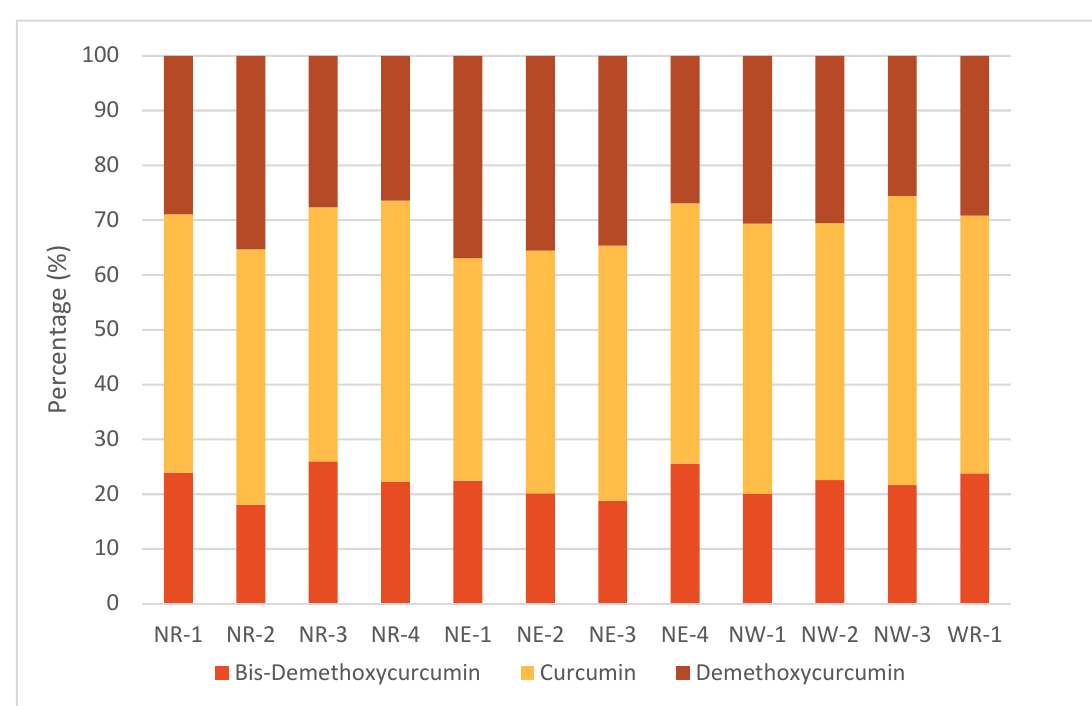
Figure 14. Percentage contents of CUR, DMC and BDM curcuminoids by UPLC-DAD for C. longa extracts.